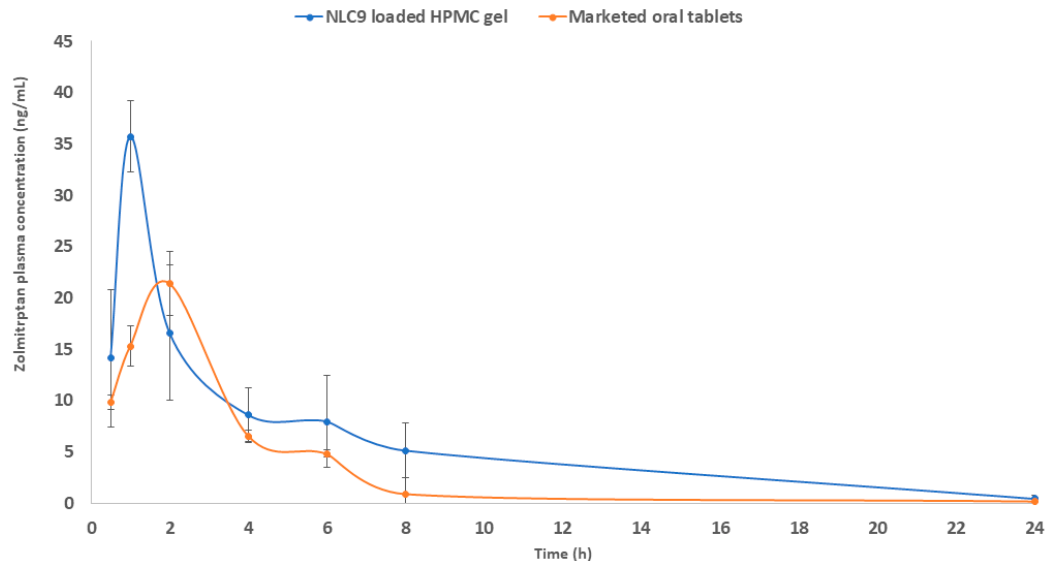
Figure 10. Mean plasma concentrations (ng/mL) of zolmitriptan after transdermal delivery of NLC9-loaded HPMC gel compared to the oral marketed product (Zomig ® ). Table 5. Pharmacokinetic parameters of zolmitriptan after transdermal administration of NLC9- loaded HPMC gel in comparison to marketed oral tablets (Zomig ® ) a,b .